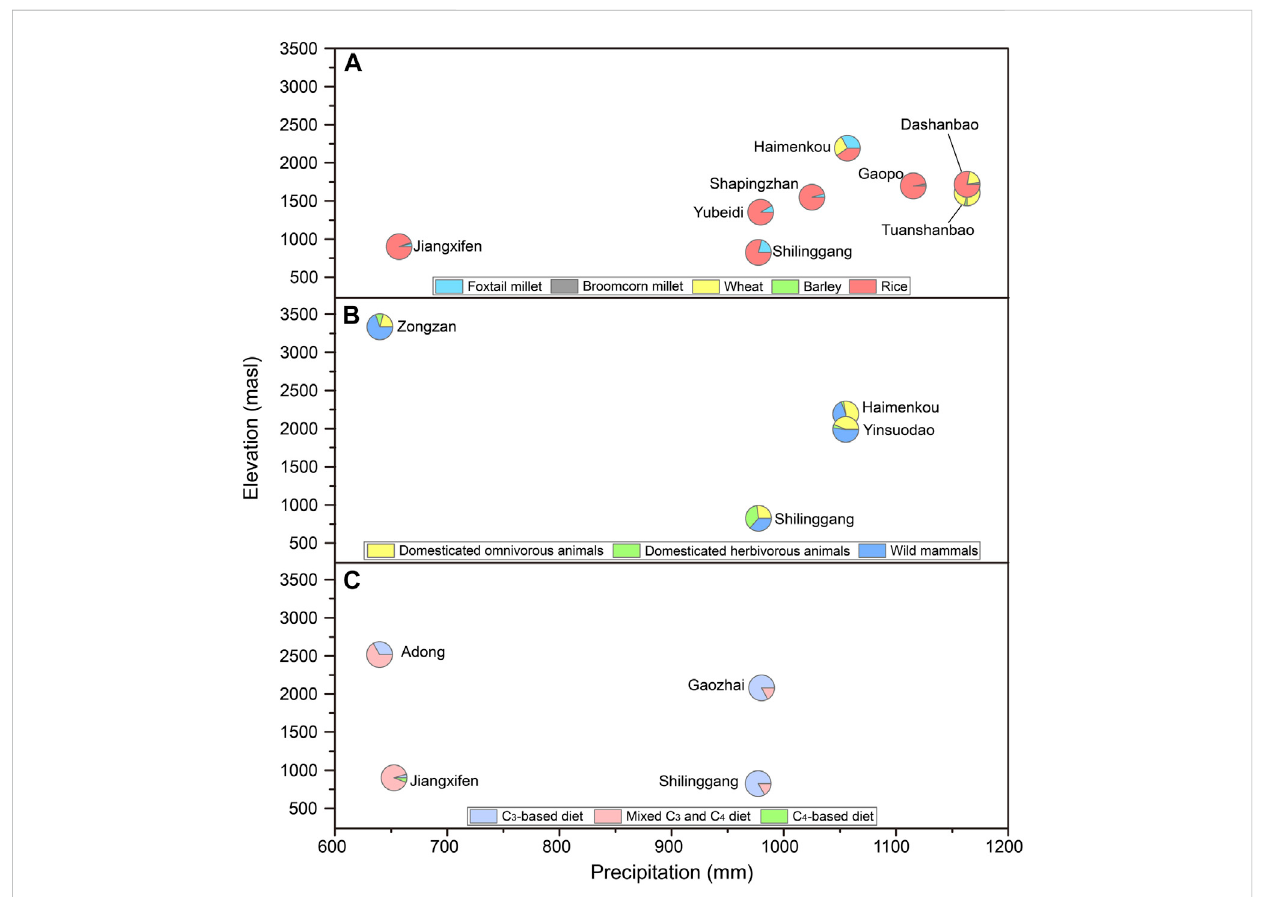
FIGURE 3 Elevation and precipitation variation in the distribution of sites with (A) crop remains; (B) animal remains; and (C) carbon isotopic signals of human bone collagen in HMR during the Bronze